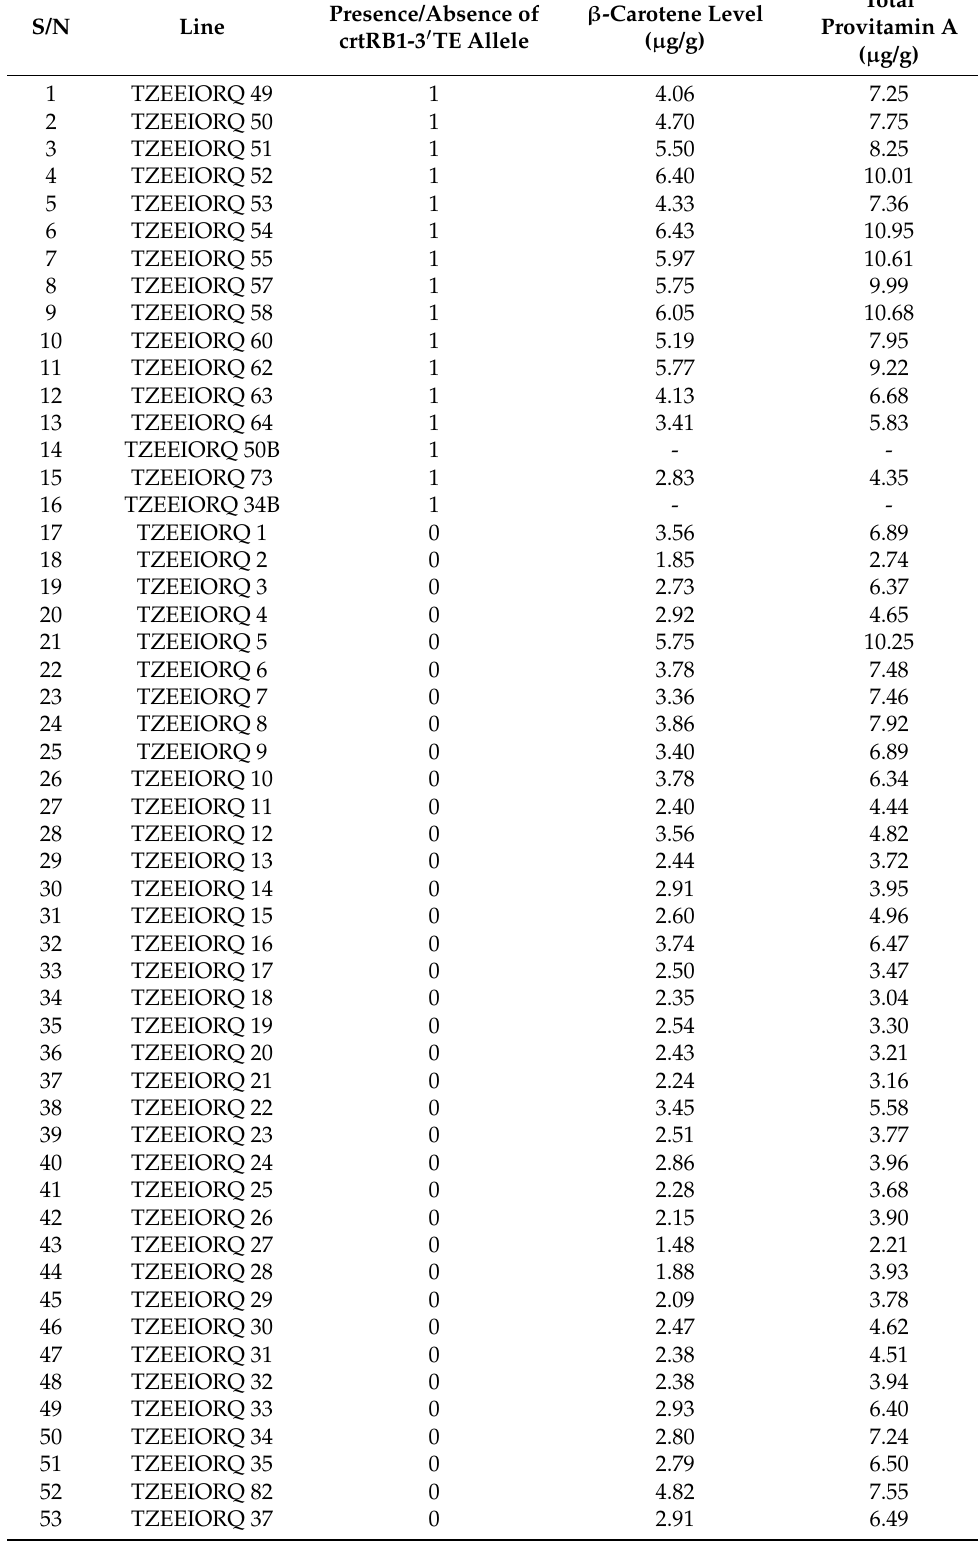
Table 7. Tropical Zea extra-early maturing provitamin A quality protein maize inbreds with and without favorable allele for provitamin A marker crtRB1-3 (cid:48) TE and corresponding levels of beta carotene and total provitamin A as determined by high-performance liquid chromatography.